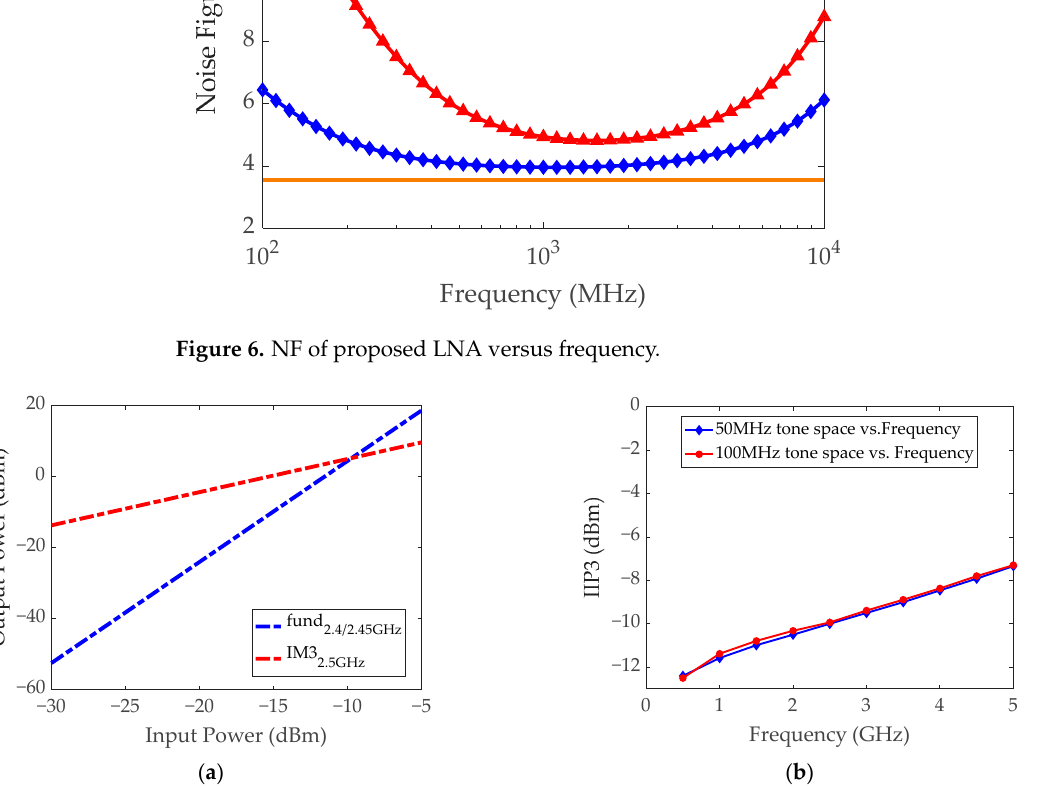
Figure 6. NF of proposed LNA versus frequency.